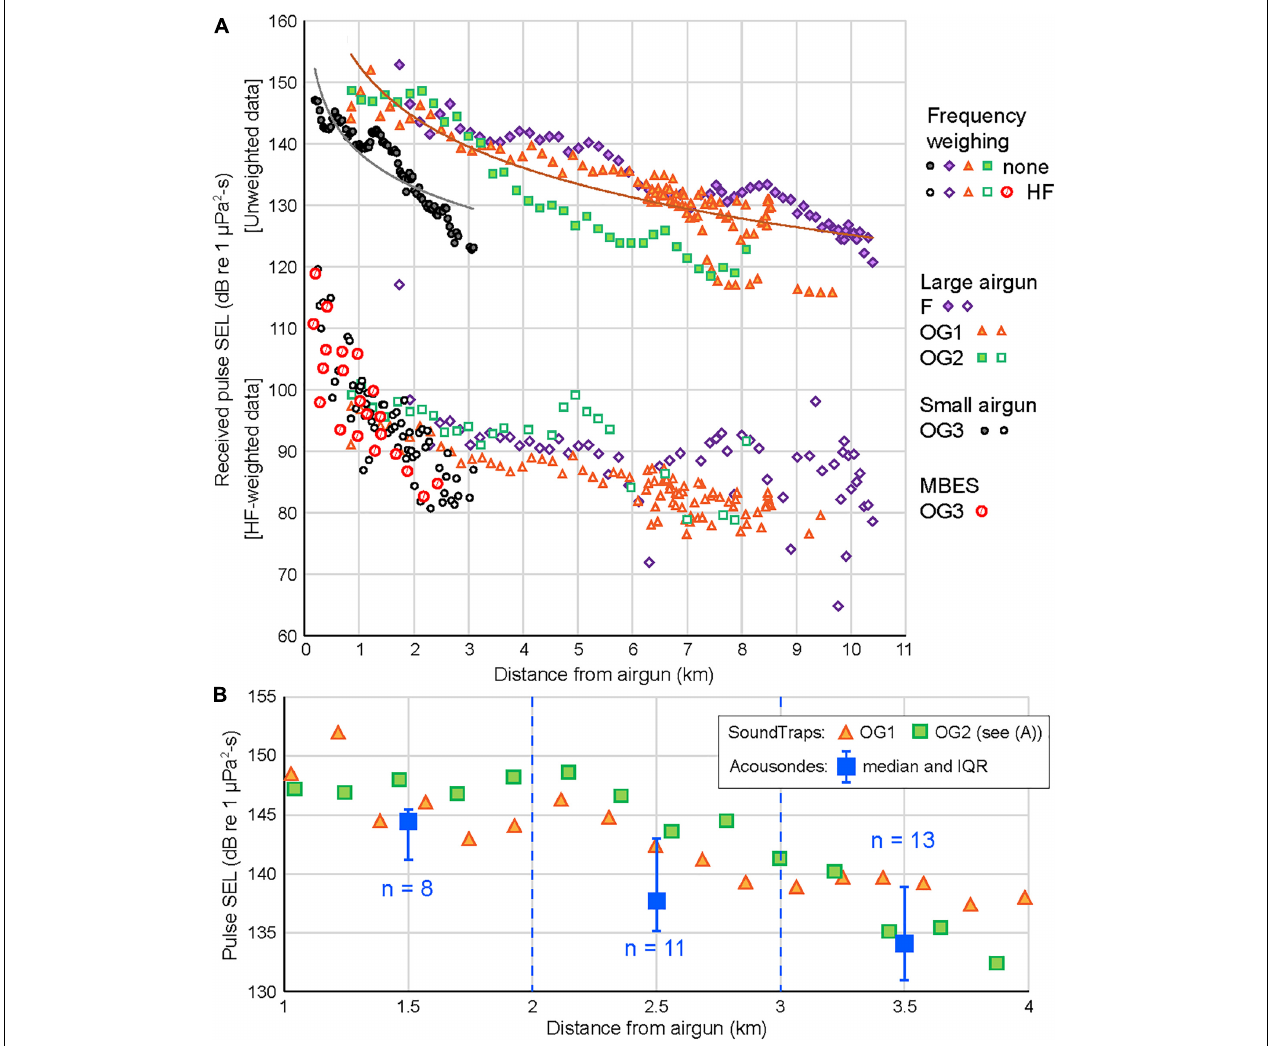
FIGURE 5 | Received levels of sound from airgun pulses, as recorded (A) by SoundTraps during SSVs in Fønfjord (F), and Outer Gåsefjord (OG) at depths of 10 m. Unweighted (filled symbols) and HF-weighted (empty symbols) sound exposure level (SEL) as a function of distance for the small airgun (3.4 L or 210 in. 3 , black symbols) and large airgun (17.0 L or 1,040 in. 3 , colored symbols). The lines are logarithmic regressions through the data points for each gun size. Received HF-weighted SELs for pulses from the MBES are also shown. (B) Comparison of received unweighted SELs at SoundTraps [symbols as in panel (A) ] with